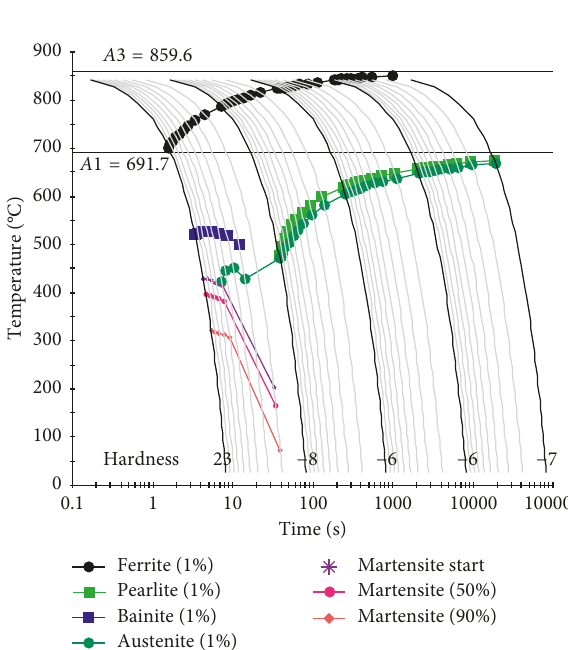
Figure 3: Phase transition diagram of the weld bead.